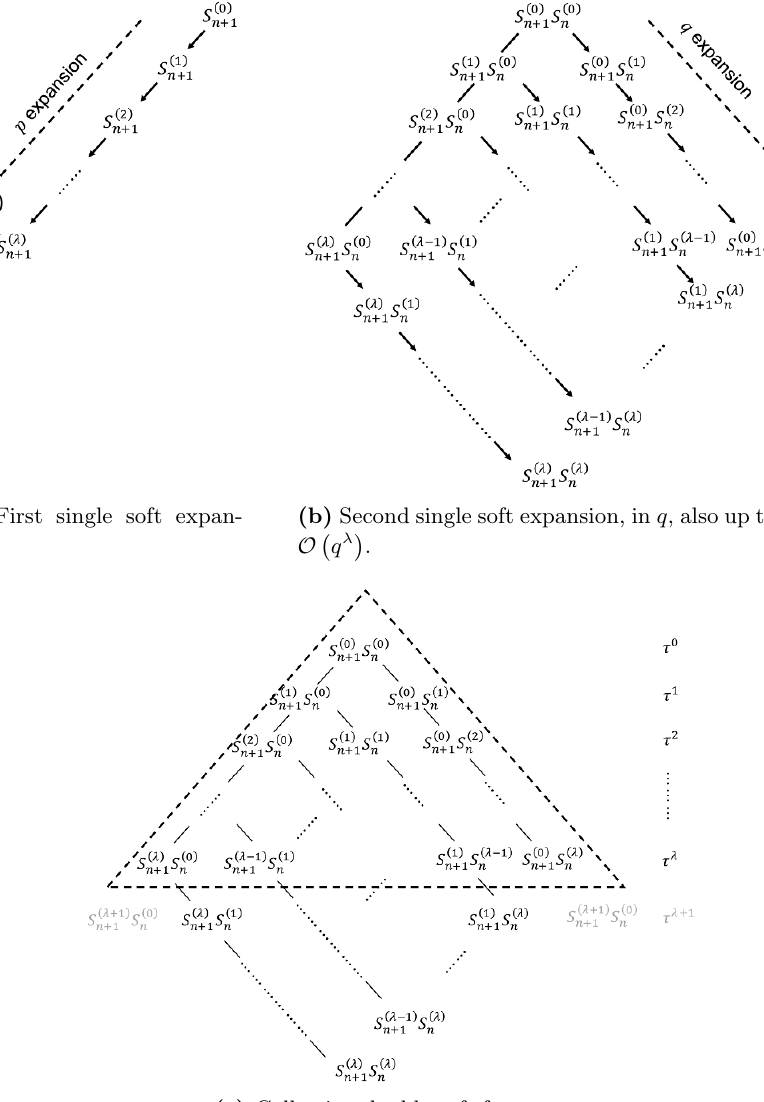
(cid:0) (cid:1) p (cid:21) . (b) Second single (cid:0) (cid:1) q (cid:21) . (c) For double soft order higher than (cid:28) (cid:21) +1 , there are